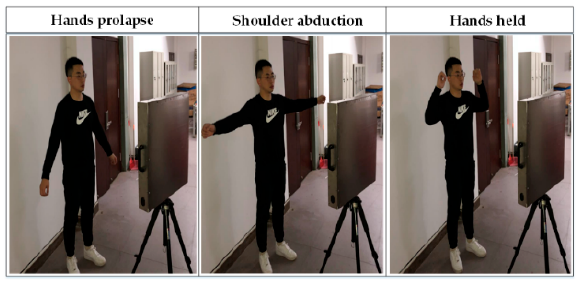
Figure 9. The scene of real data measurement.